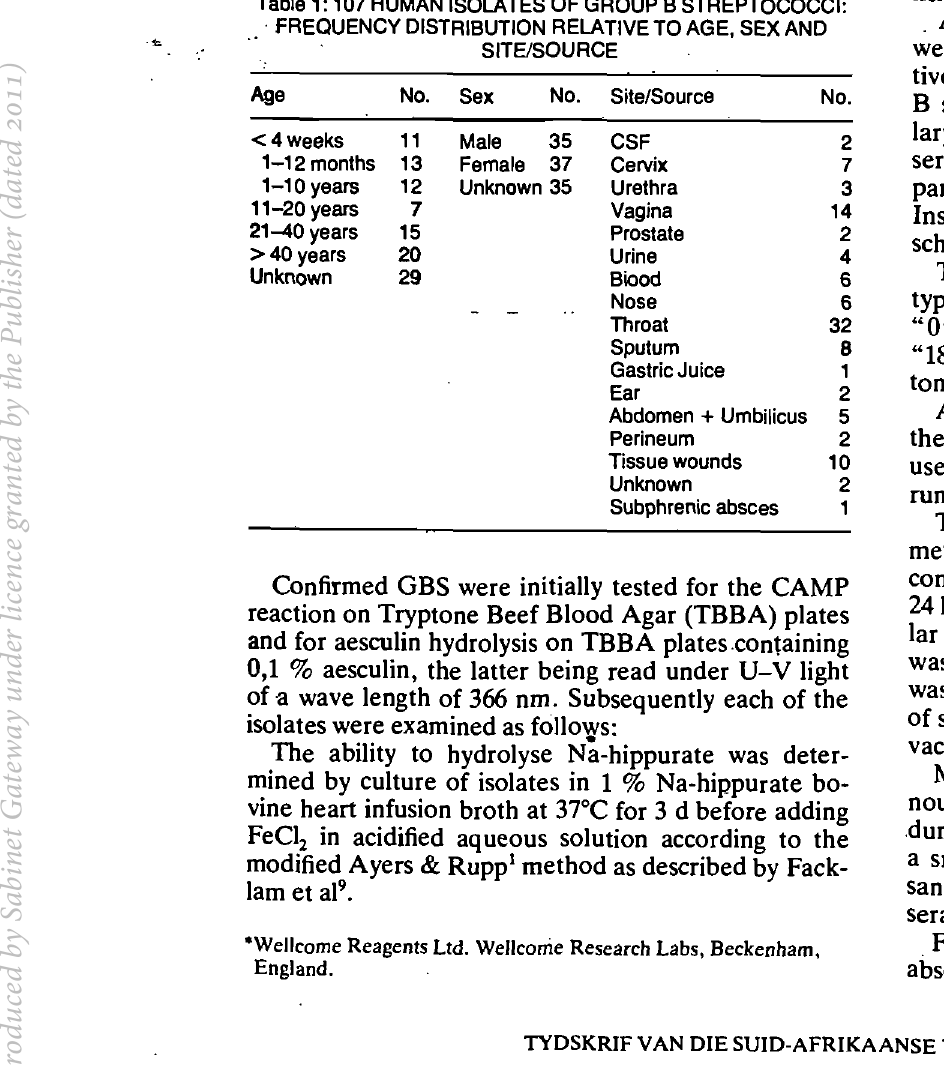
Table 1: 107 HUMAN ISOLATES OF GROUP B STREPTOCOCCI: . FREQUENCY DISTRIBUTION RELATIVE TO AGE, SEX AND